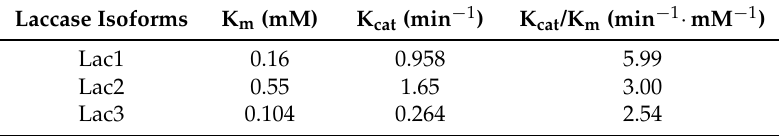
Table 3. Kinetic constants of purified P. nebrodensis laccases for